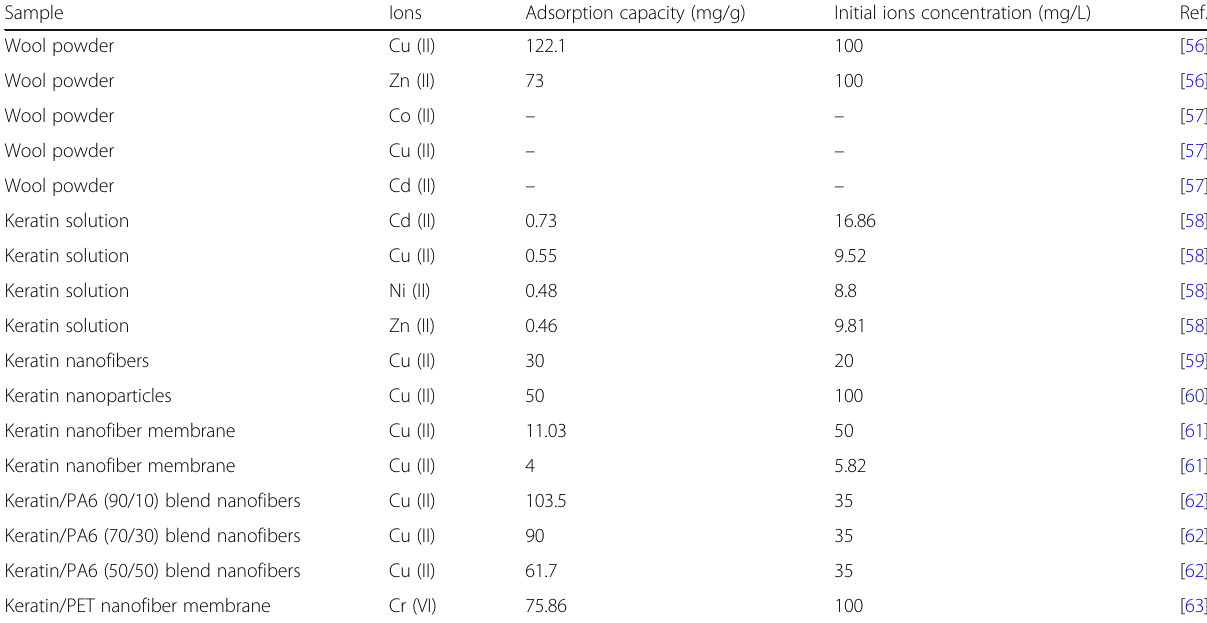
Table 2 Metal ions adsorption performances of various wool particle-based materials